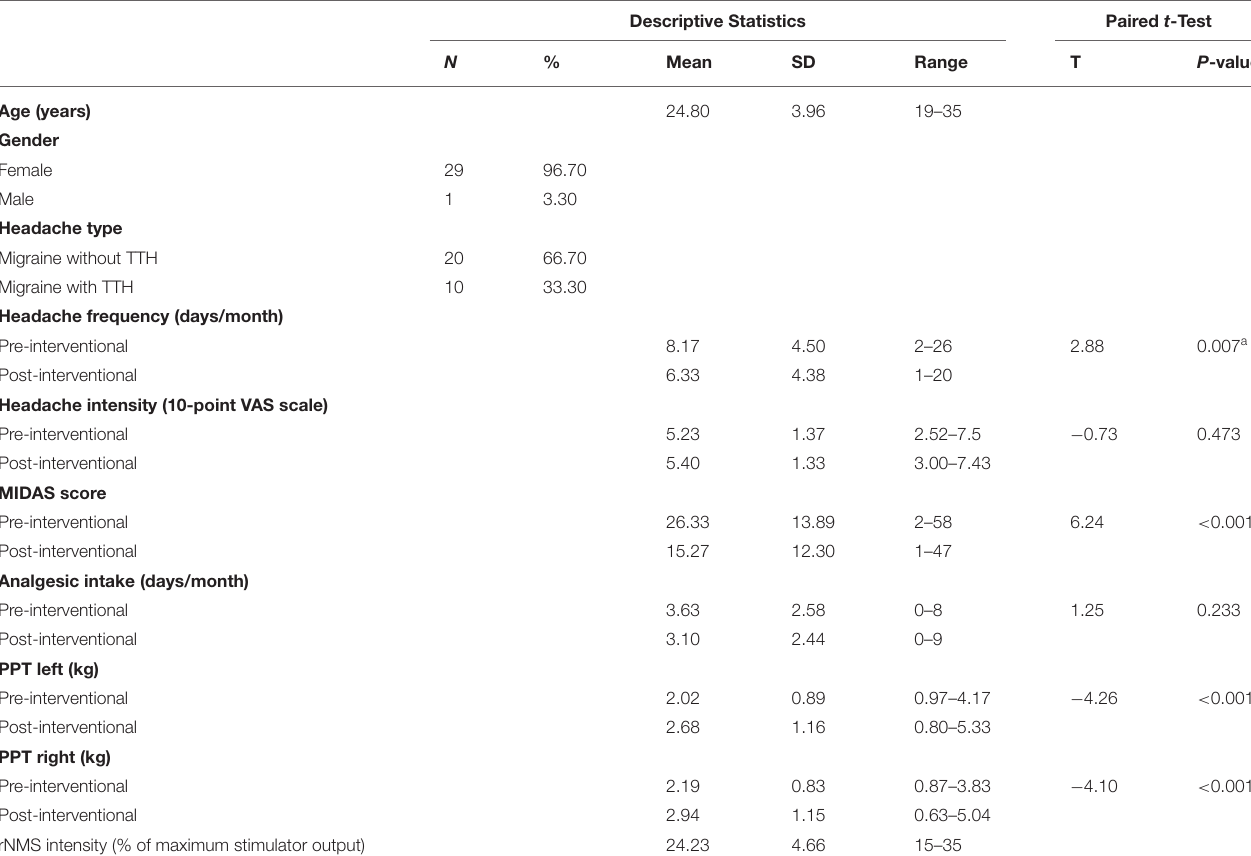
TABLE 1 | Descriptive statistics of n = 30 patients affected by episodic migraine participating in two pilot studies of repetitive neuromuscular magnetic stimulation applied to the trapezius muscles. Descriptive Statistics Paired t